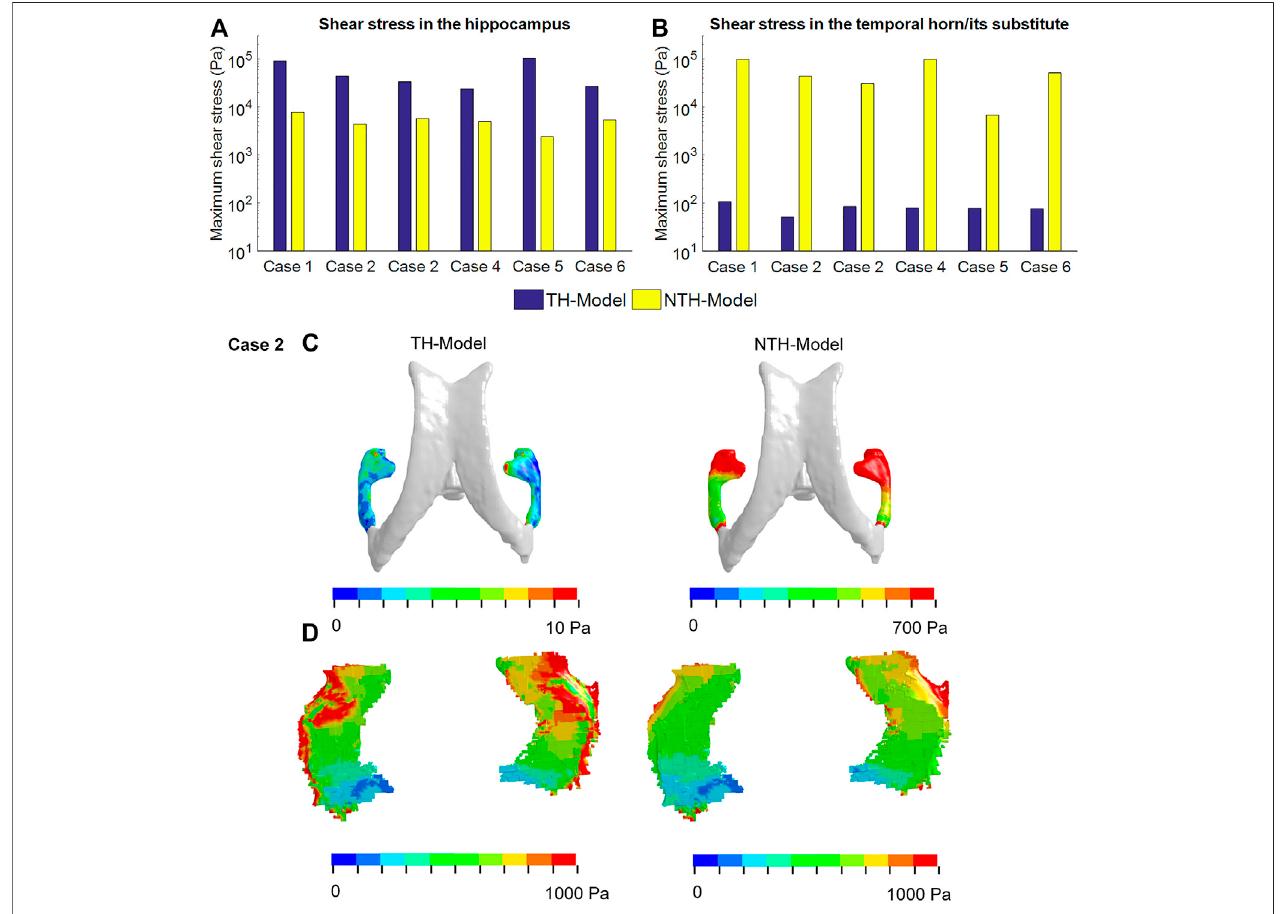
FIGURE 6 | Maximum shear stresses in the hippocampus (A) and temporal horn/its substitute (B) predicted by the TH-Model and NTH-Model in six cases; (C) Contours of maximum shear stress in the CSF within the temporal horn in the TH-Model and its substitute in the NTH-Model; (D) Contours of maximum shear stress endured by the hippocampi in the TH-Model and NTH-Model. Note that, in the NTH-Model, the temporal horn is modeled as brain, not fl uid.